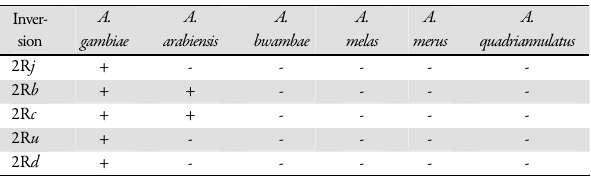
Tab. 1. Simple identification key for identifying the sibling species of A. gambiae complex using common polymorphic inversions. (Tab. derived from Coluzzi et al. , 2002 and George et al. , 2010)